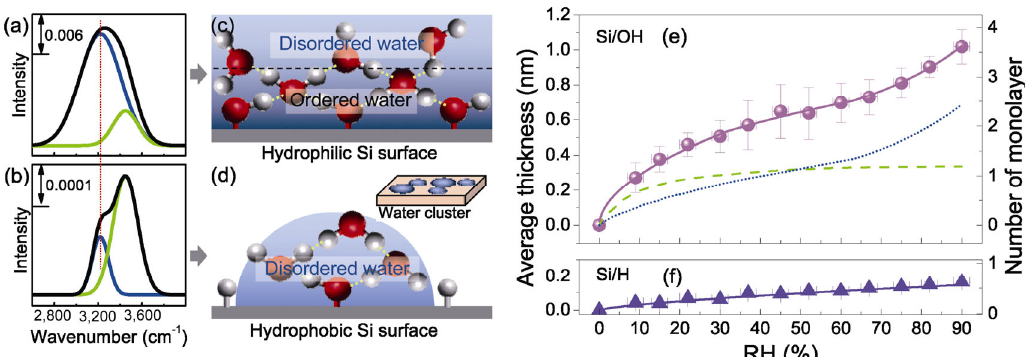
Fig. 4 Schematic of ATR-IR spectra of O–H stretching region of water adsorbed on (a) hydrophilic hydroxyl-terminated silicon (Si/OH) surface; (b) hydrophobic hydrogen-terminated silicon (Si/H) surface; (c) Si–OH surface (showing corresponding adsorbed water structure); and (d) Si–H surface in humid air. Inset in (d) shows schematic of clusters of water molecules on hydrophobic Si–H surface; (e, f) illustrate adsorption isotherms of adsorbed water on hydrophilic Si–OH and hydrophobic Si–H surfaces, respectively. Solid line is drawn as guide. Green dashed and blue dotted lines represent the thicknesses of disordered and ordered water, respectively. Number of layers is calculated by dividing average thickness with average diameter of water molecule (2.82 Å). Reproduced with permission from Ref. [67], © American Chemical Society